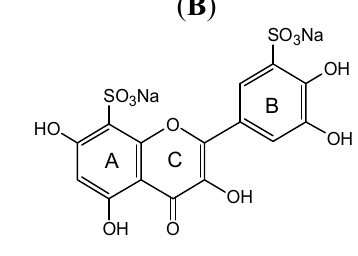
-intoxicated group. † p < 0.05 4